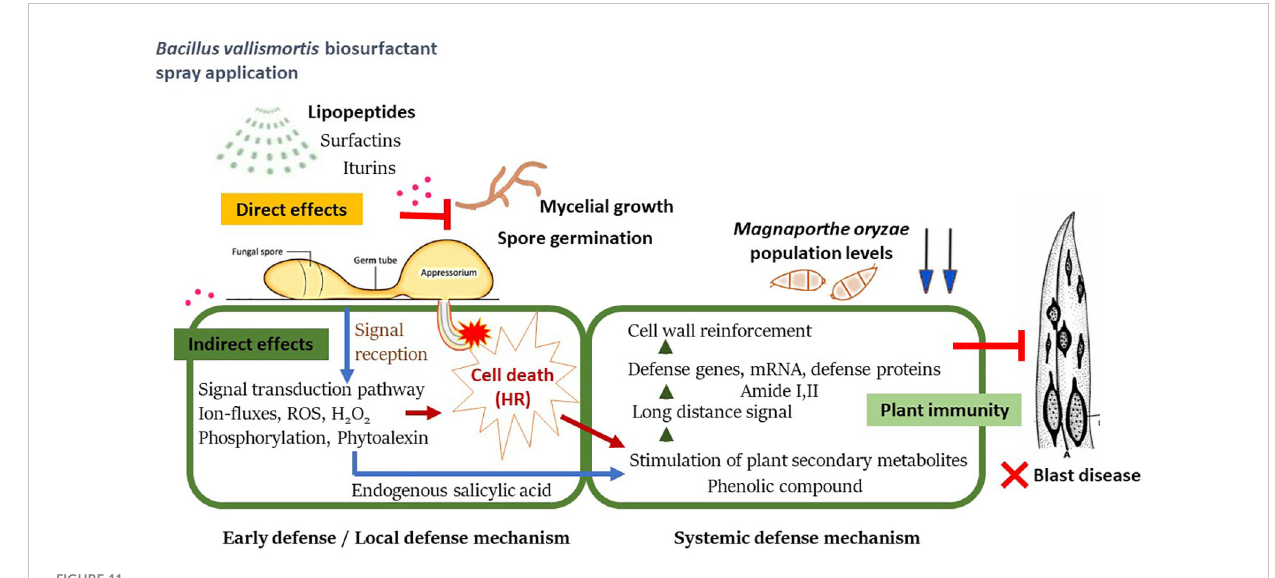
FIGURE 11 A proposed schematic model of systemic resistance in rice plant against Magnaporthe oryzae after being treated with Bacillus vallismortis